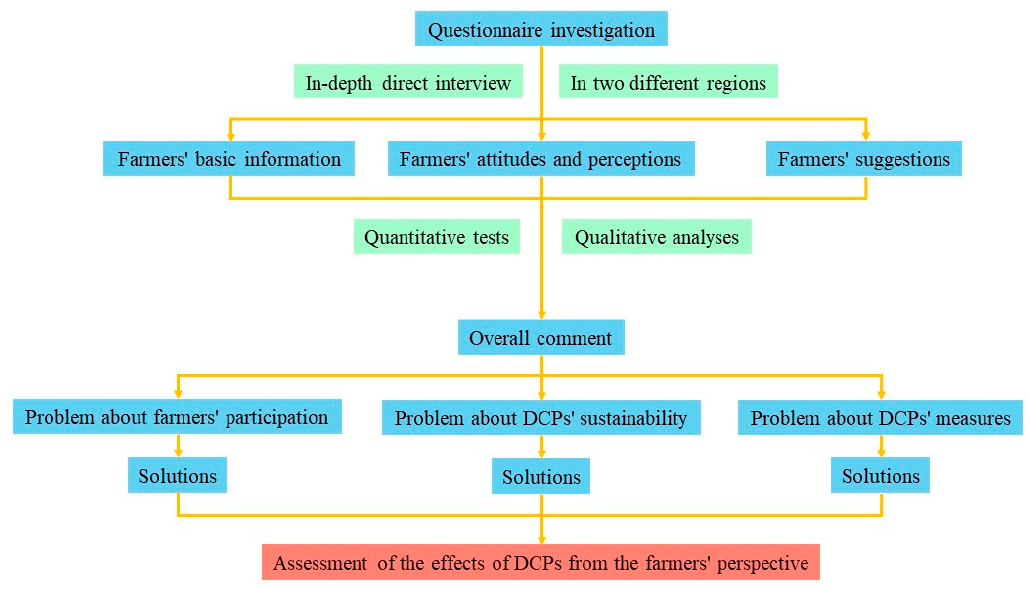
Figure 1. Conceptual framework for assessing the effects of the desertification control projects (DCPs) from the farmers’ perspective.